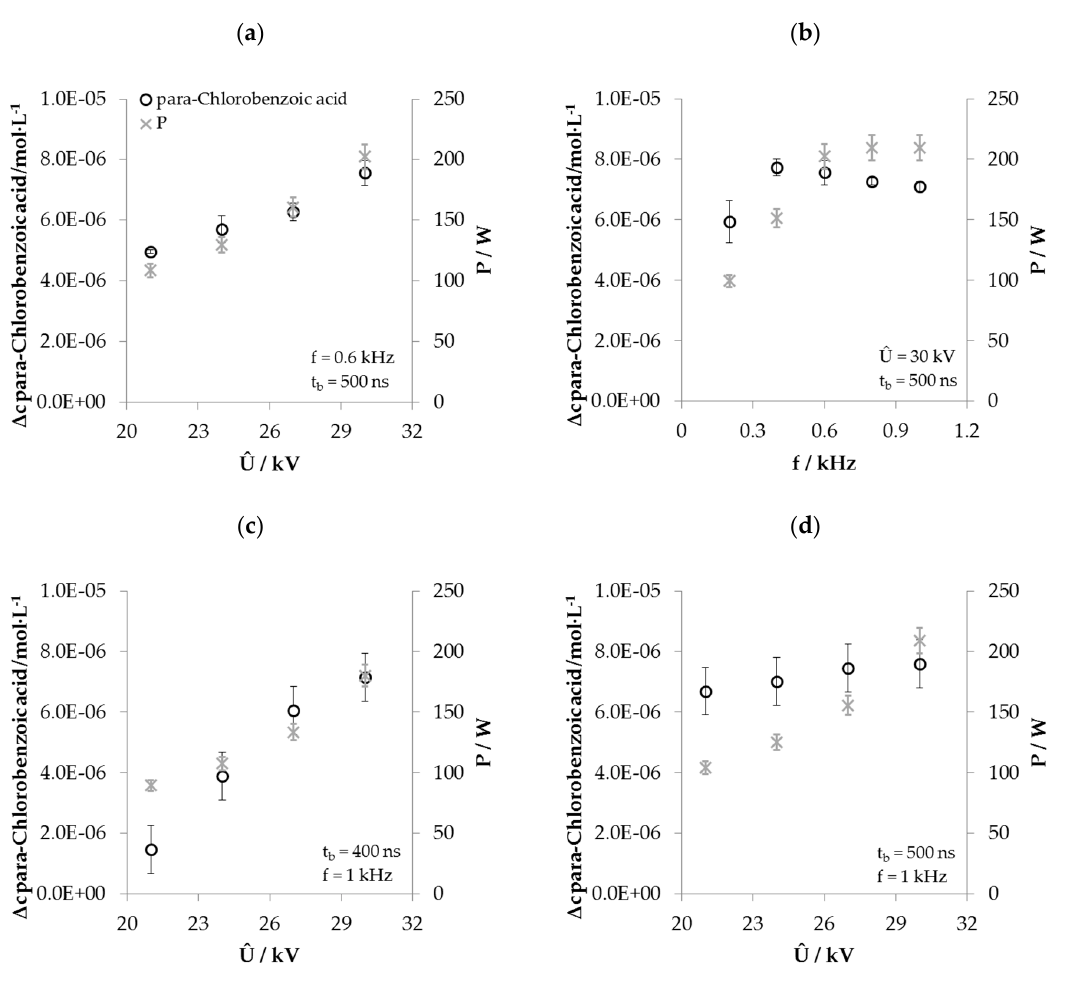
Figure 3. Decrease of para-Chlorobenzoic acid concentration ( ∆ c ) and related power consumption P of the HV generator as a function of ( a ) voltage amplitude Û , ( b ) pulse repetition rate f , and ( c ) and ( d ) pulse duration t b .